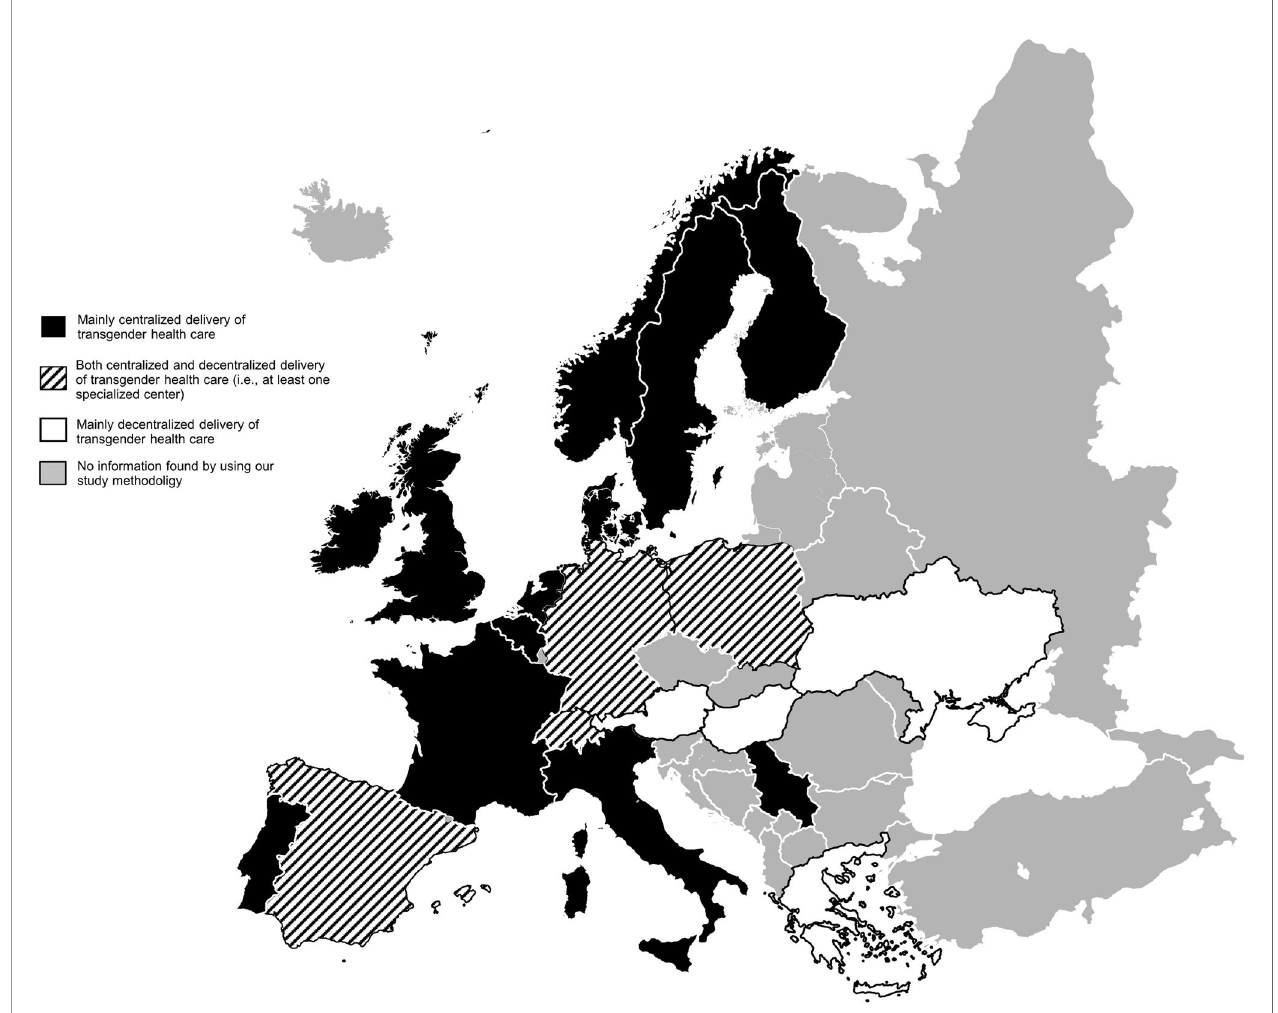
FIGURE 4 | Transgender health care delivery in